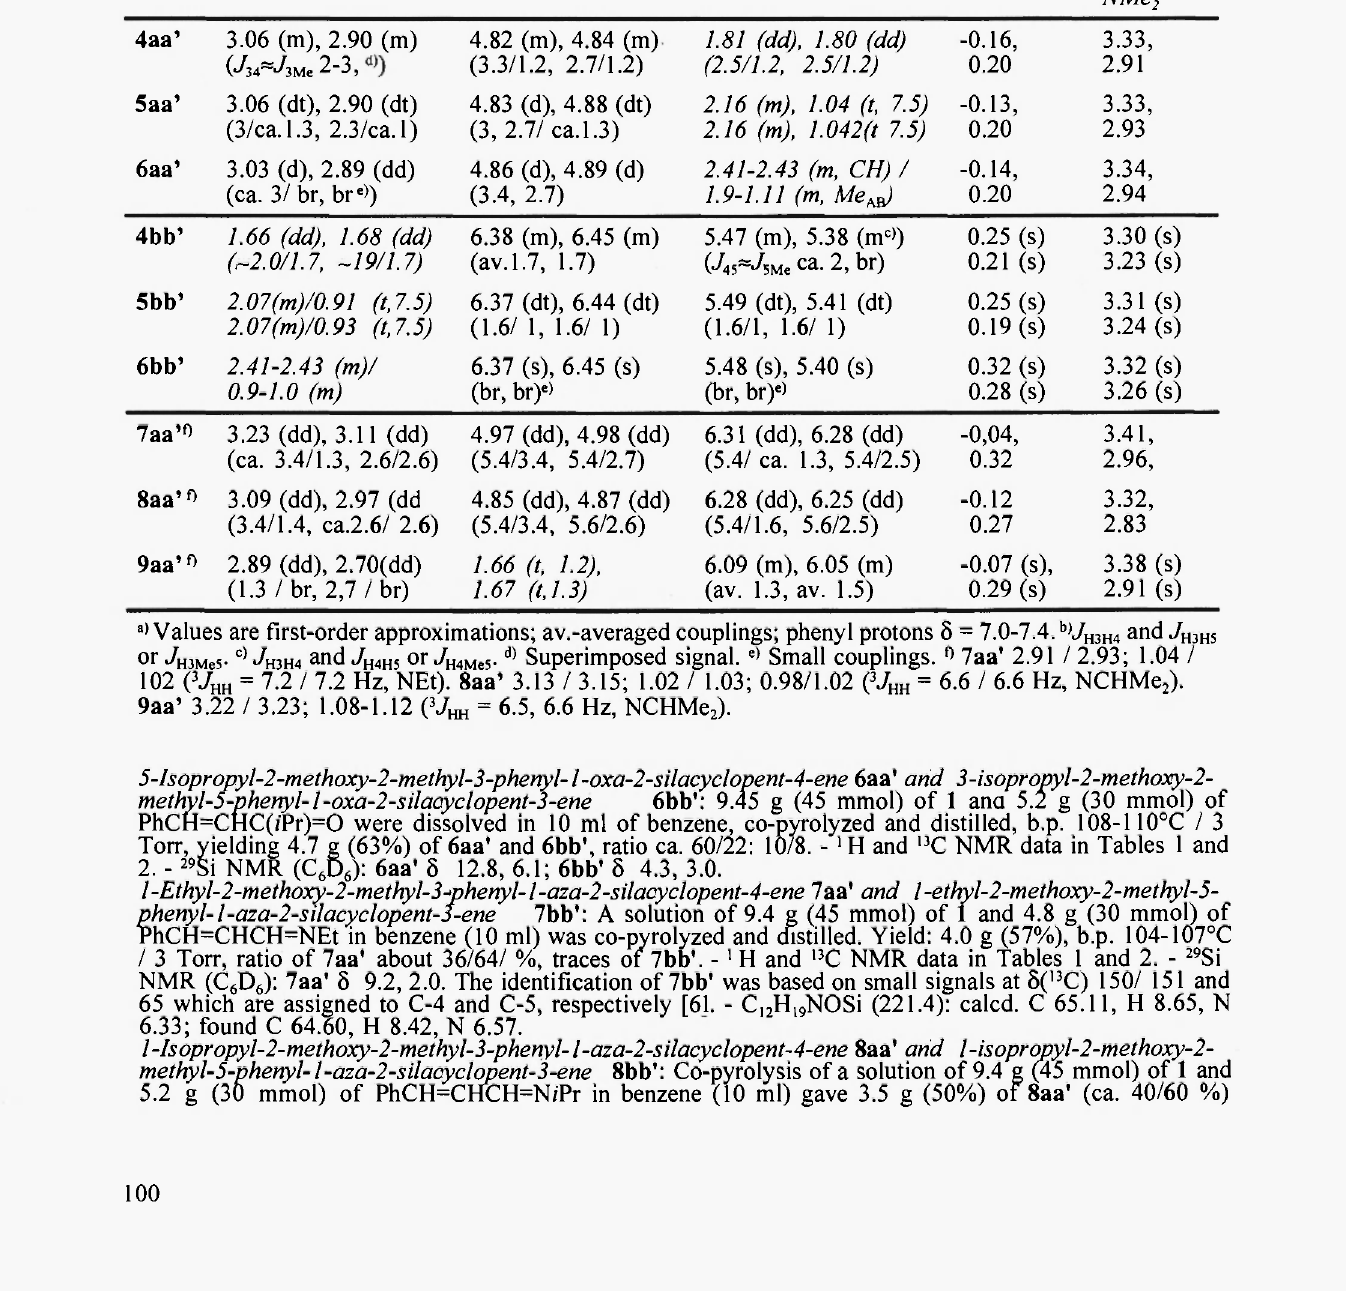
Table 1. Characteristic Ή-NMR chemical shifts of the oxa- and azasilacyclopentenes 4-9 a) , ö(C 6 D 6 , TMS),